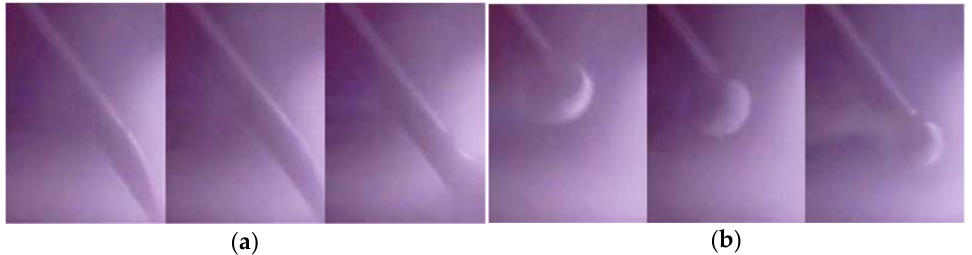
Figure 3. ( a ) Normal metal transfer shape; ( b ) abnormal metal transfer shape.